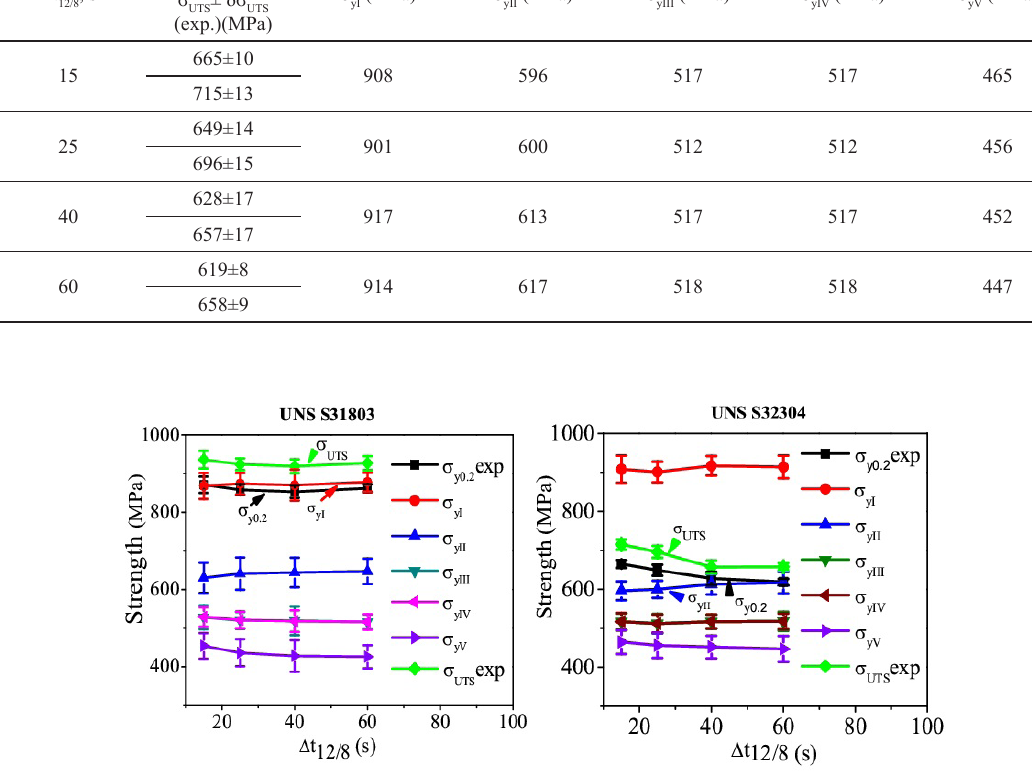
) and ultimate tensile strengths (σ Table 7. Experimental yield (σ y0.2 σ corresponding to the HAZ microstructures at the tested cooling times in the UNS S32304 DSS. The σ yI-V receive samples were 661 MPa and 718 MPa respectively. Δt , s 12/8